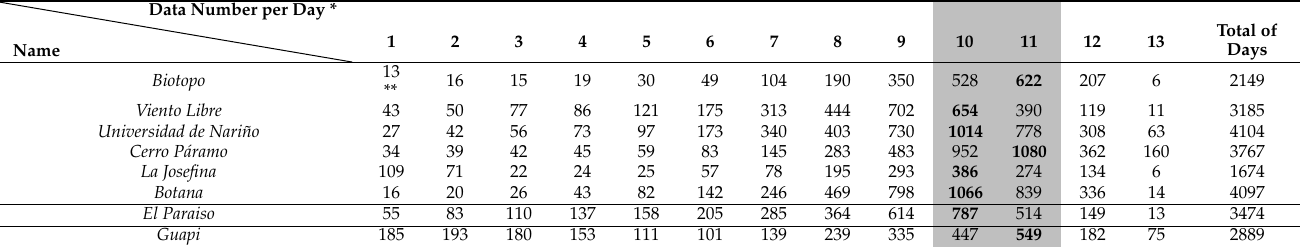
Table 7. Classification of days according to irradiance recording per day. The rows contain the number of days classified by the amount of measured data between the 6:00 and 18:00 per